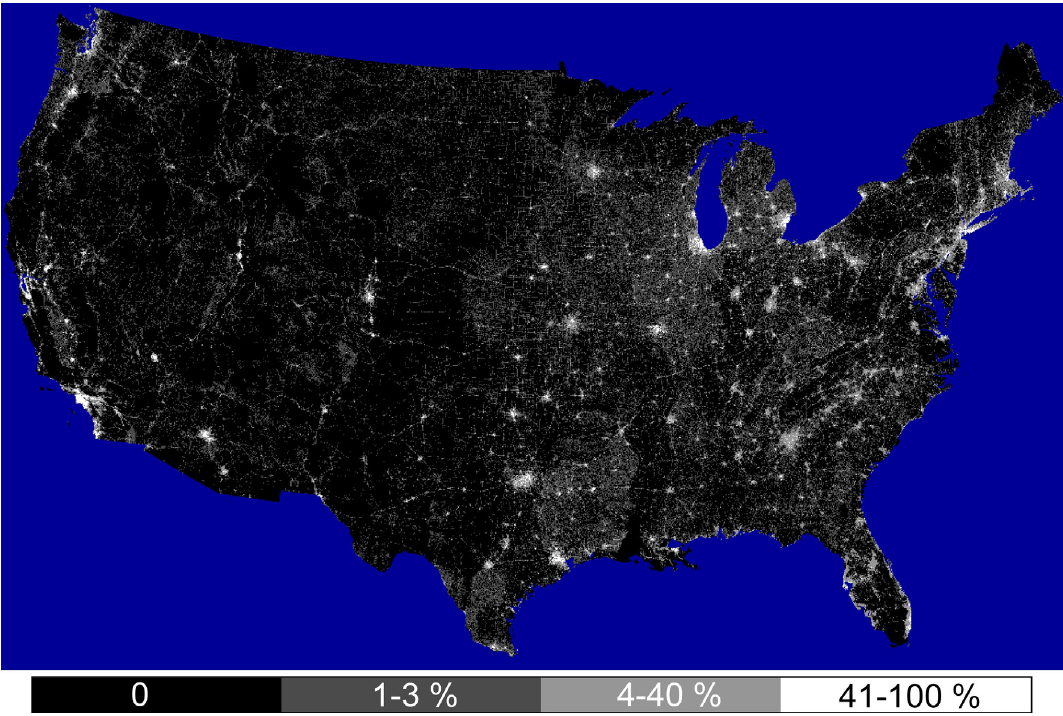
Figure 1. The USGS’ Landsat derived ISA density data for the conterminous USA were used in developing the calibration for the global ISA product. The 30 meter resolution ISA data were aggregated to a one km 2 Albers equal area grid. The percent cover of ISA has been coded into four gray scale